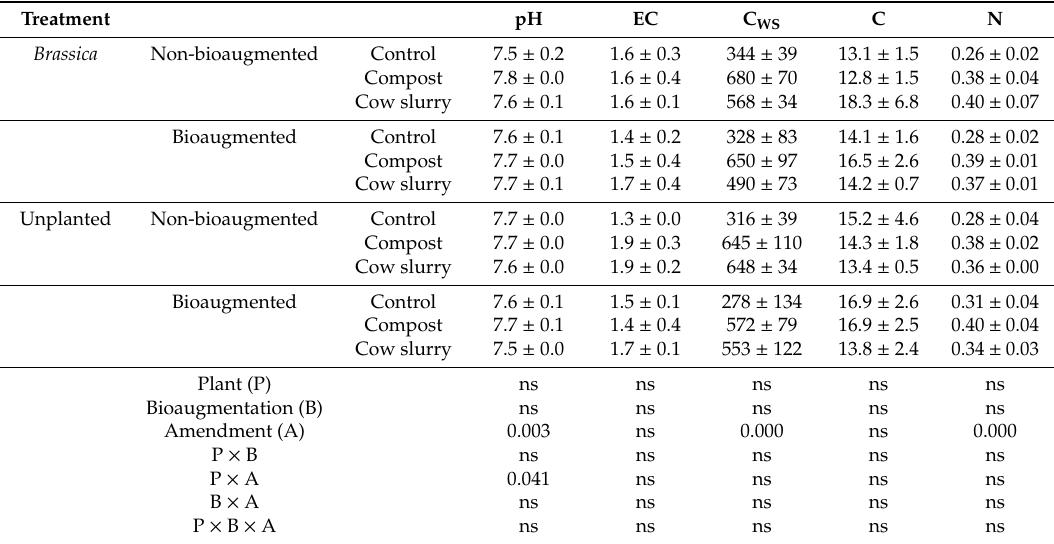
manure; Cow slurry: amended with dried cow